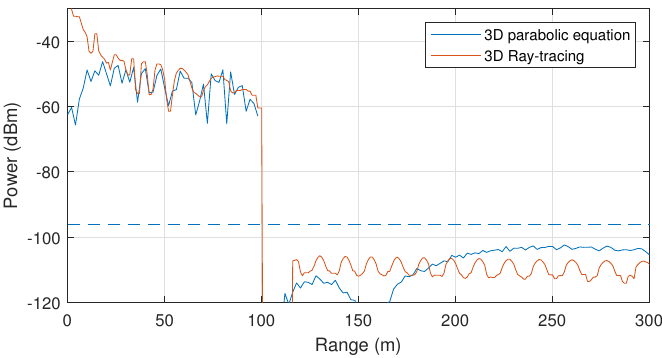
Figure 5. Diffraction on a cuboid. Distribution of the signal level at the height of 1.5 above the